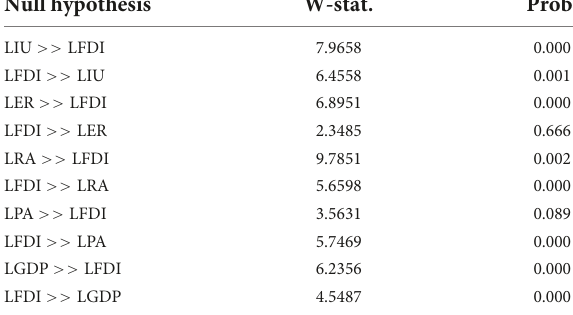
TABLE 7 Results of D-H panel causality